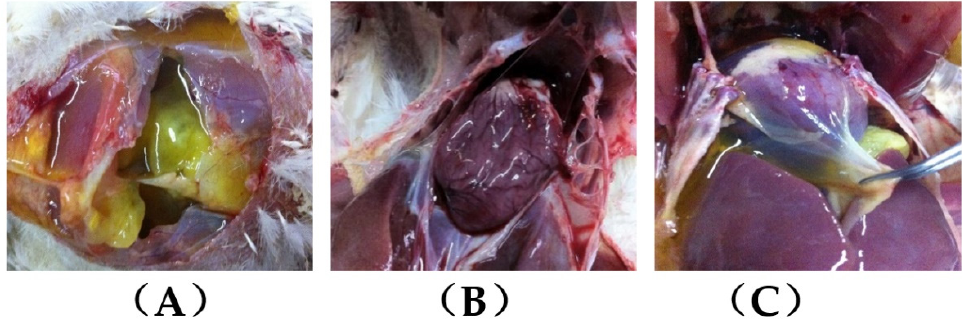
Figure 1. Autopsy results of AS broilers: ( A ) accumulation of large amounts of yellowish and clear fluid in the abdominal cavity without any fibrous clots; ( B ) the right ventricle shows flaccidity and poor elasticity; ( C ) pericardial effusion was observed in the heart.